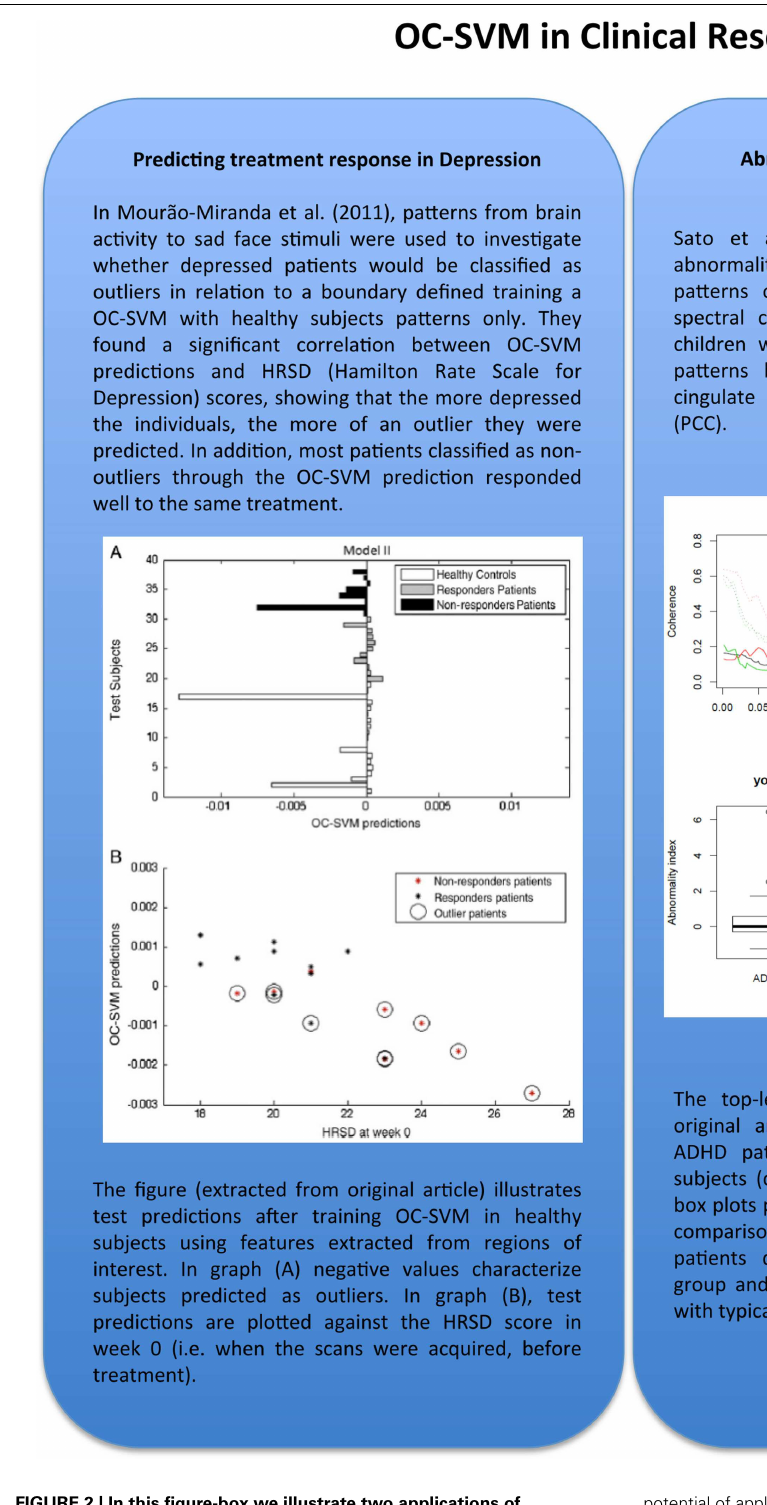
FIGURE 2 | In this figure-box we illustrate two applications of OC-SVM in studies involving different neuropsychological conditions: major depression disorder and attention-deficit/ hyperactivity disorder (ADHD), both addressing the question of defining a boundary characterizing distributions of brain activation patterns from a normal population. These papers are among the pioneer works representing important proof of concept that shows the